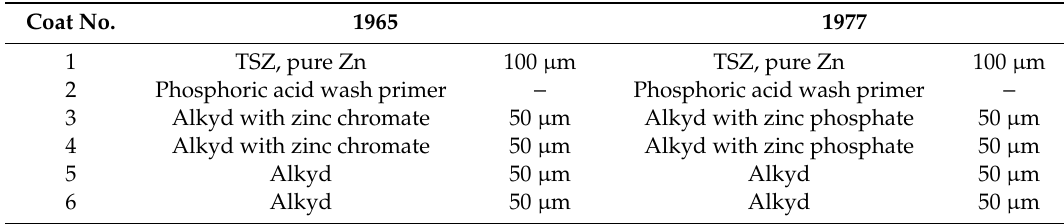
Table 2. The coating specifications between 1965 and